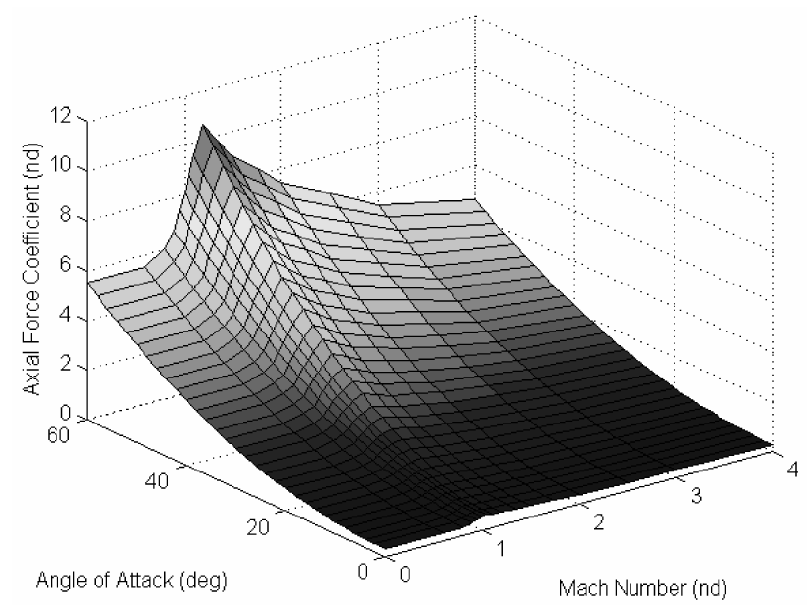
Fig. 1. Body axial force coefficient (nd).